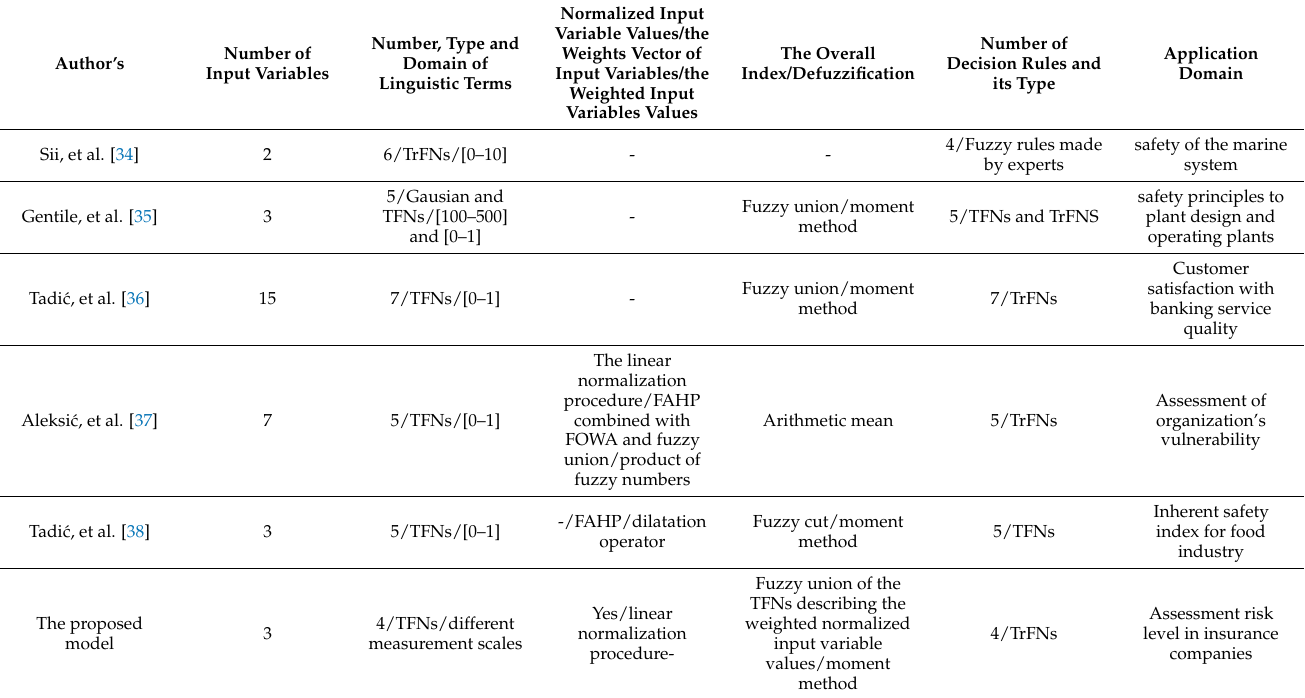
Table 2. Fuzzy IF-THAN